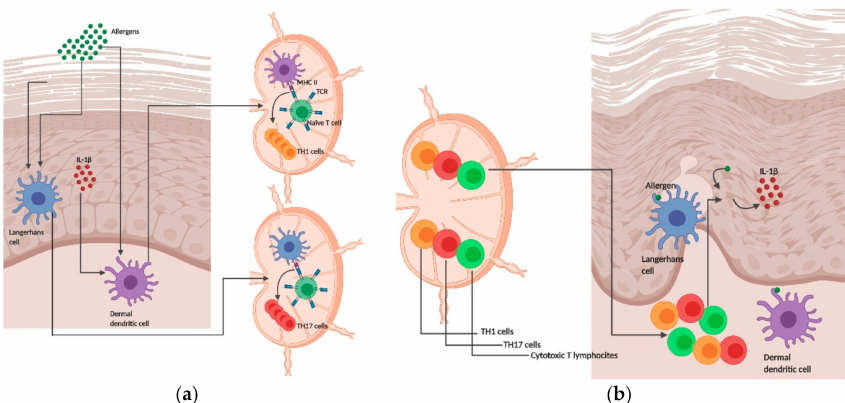
Figure 1. Schematic overview of the mechanisms underpinning skin sensitization during sensitization ( a ) and elicitation ( b ) phases: ( a ) Allergens penetrate the skin and are captured and processed by antigen-presenting cells (APCs), Langerhans cells (LC) and dermal dendritic cells (DCs). Concomitantly, the allergen promotes the release of interleukin (IL)-1 β and other proinflammatory cytokines, contributing to the amplification of the immune reaction. Then, LC and DC leave the skin and migrate to skin-draining lymph nodes where they present the antigen to naïve T cells—priming, through the interaction of the major histocompatibility complex (MHC) II with T cell receptor (TCR) complex. This interaction triggers naïve T cells proliferation and di ff erentiation into CD4 + and CD8 + cells. CD4 + and CD8 + T cells can further di ff erentiate into other cell types, depending on the APC evoking the di ff erentiation. ( b ) Upon re-exposure to the same allergen the di ff erentiated cells migrate to the skin where they exert distinct functions. For example, cytotoxic T lymphocytes promote the apoptosis of keratinocytes expressing IL-1 β and other proinflammatory cytokines. In parallel, CD4 + regulatory T cells migrate to the challenge site and promote inhibition of allergic contact dermatitis (ACD) and tolerance. Created with